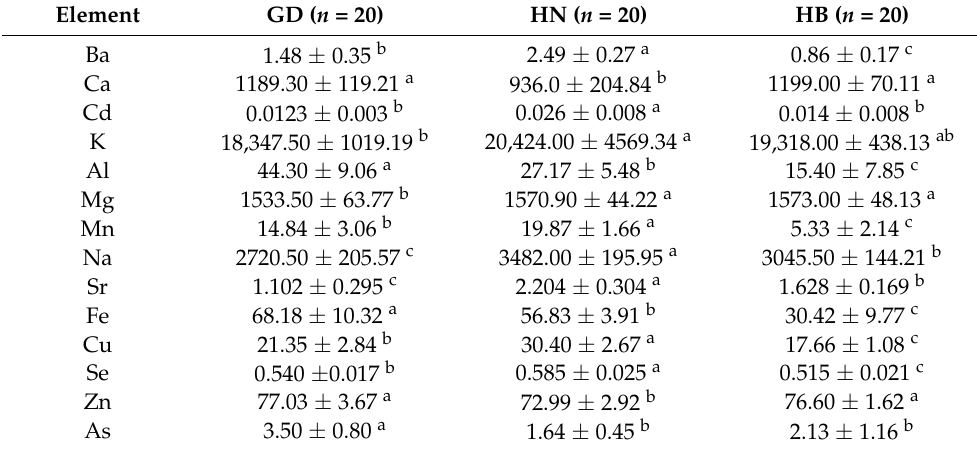
Table 3. Mineral element contents (mg · kg − 1 , of dry weight) of P. clarkii sampled from different locations.